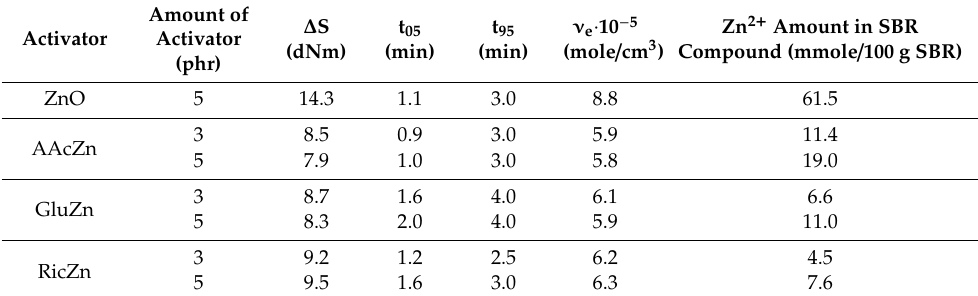
Table 2. Cure characteristics of SBR compounds at 160 ◦ C and crosslink densities of